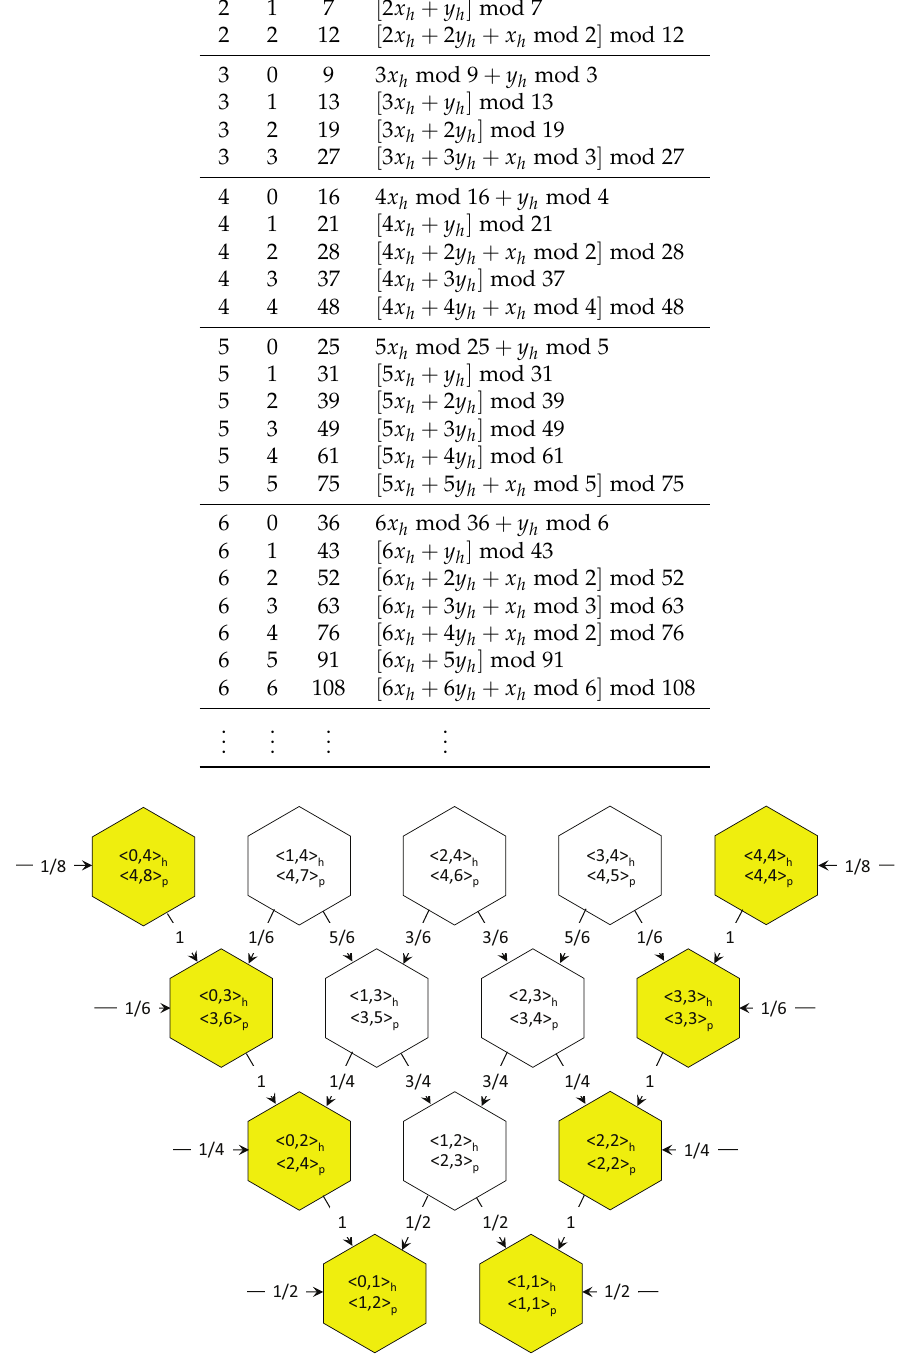
Figure 4. Routing Probabilities for Load Balancing from Ring 4 to Ring 1 in Sector S 1